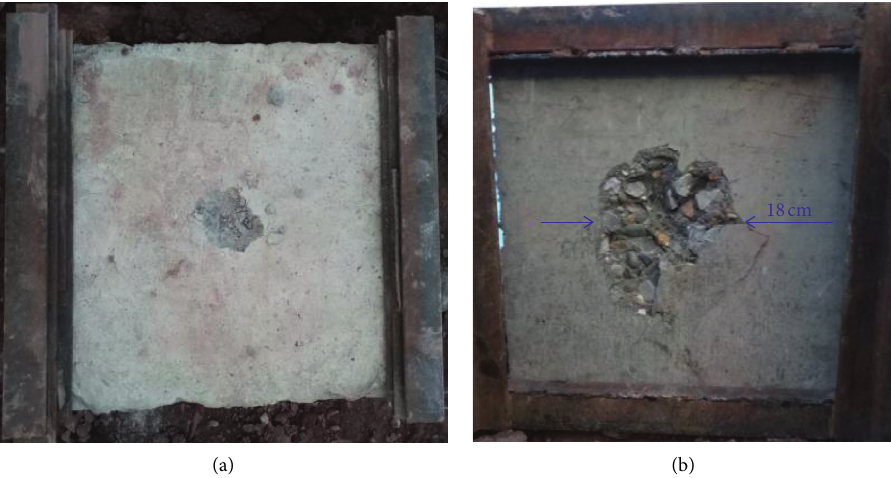
Figure 12: Test results of the spherical explosive. (a) Upper surface. (b) Bottom